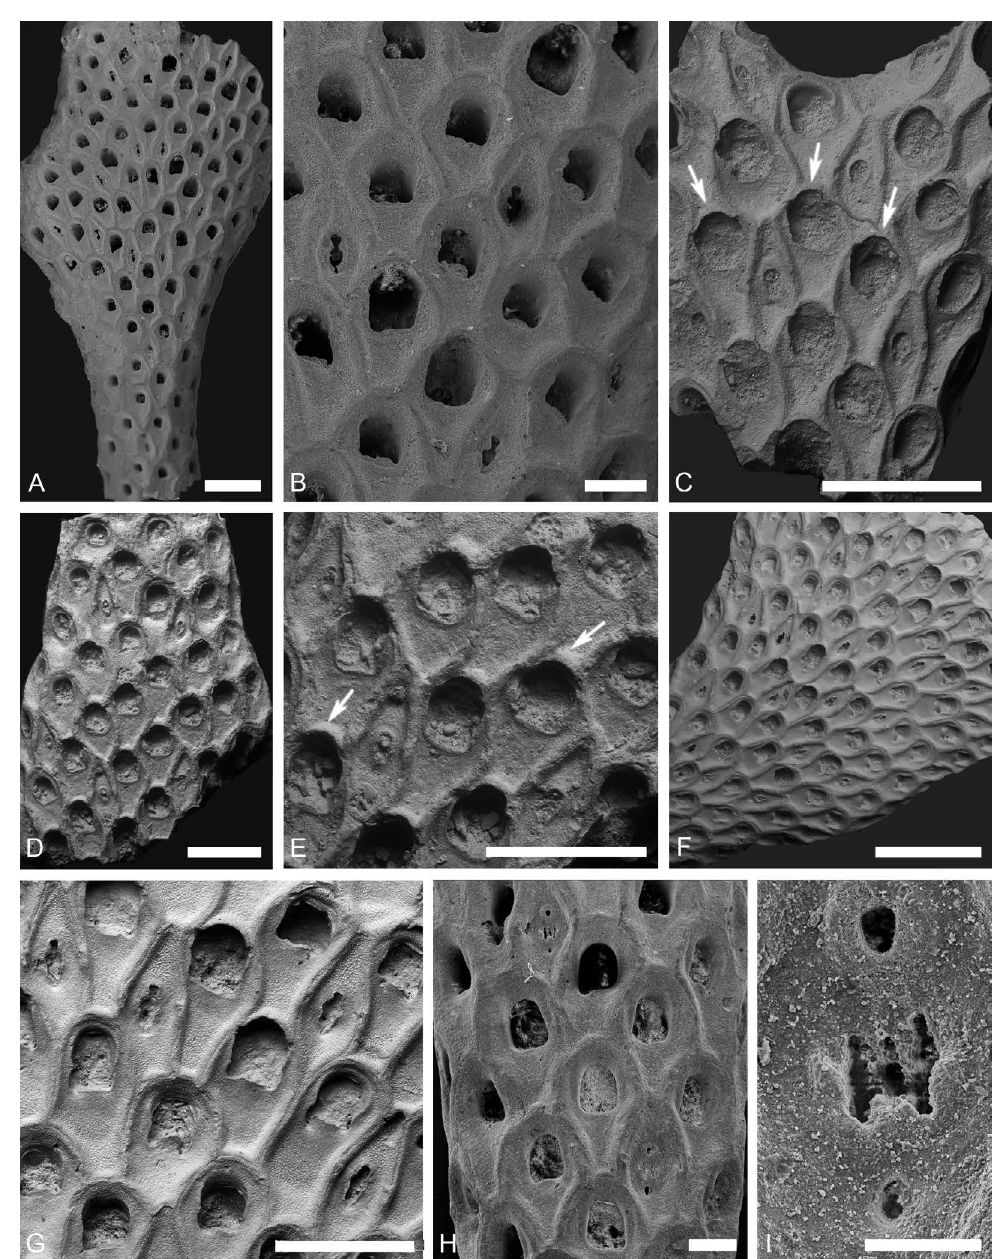
Fig. 17. Rhagasostoma rowei (Brydone, 1906). A–B . SMF 29924, late Campanian, Harmignies near Mons, Belgium. A . Overview of erect bifoliate colony. B . Autozooids and avicularia. C . TsNIGR Museum 26/12939, late Campanian, Cibicidoides voltzianus Zone, Uzbekistan, southern Aral Sea Region, erect bifoliate colony showing ovicellate (ooecia arrowed) and non-ovicellate autozooids and avicularia. D–E . TsNIGR Museum 35/9757, late Campanian, western Kopetdag, Turkmenistan. D . Erect bifoliate colony. E . Ovicellate autozooids (some ooecia arrowed) and avicularia. F–G . PIN 5502/3051, late Campanian ( Belemnitella lanceolata Zone), Kazakhstan, Emba River. F . Overview of erect bifoliate stem-like then dichotomously branching colony. G . Ovicellate and non-ovicellate autozooids and avicularia. H–I . SMF 29931, early Maastrichtian, Rügen, Germany. H . Overview of erect bifoliate stem-like colony. I . Opesia and opesiules of avicularium. Scale bars: A, C–E, G = 1 mm; F = 2 mm; B, H = 300 µm; I = 100